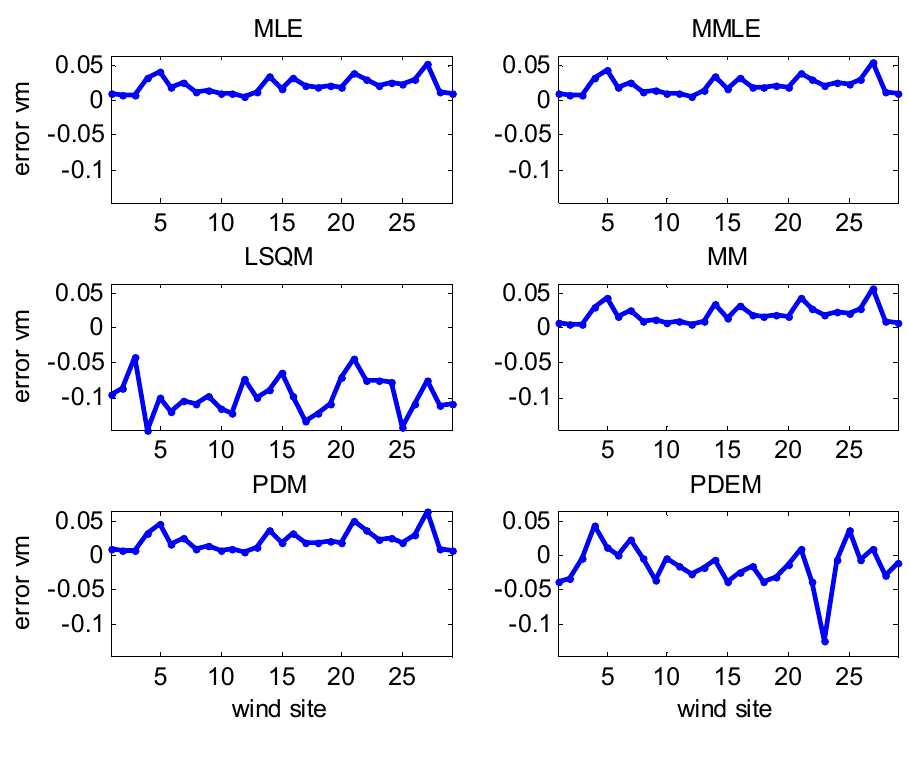
at the different wind vm